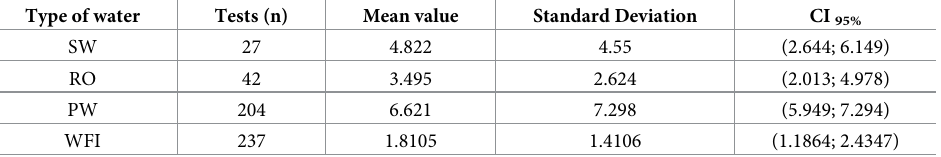
Table 3. Descriptive statistics (mean, standard deviation, and 95% confidence intervals) for each separate water type group analyzed (softened, reverse osmosis, purified, and WFI).